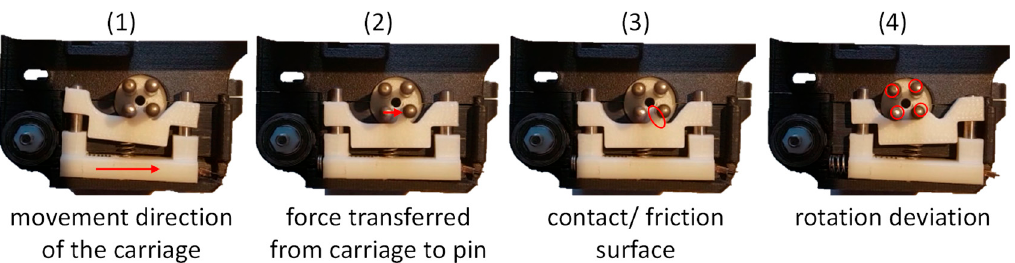
Figure 15. Representation of the sources of error during the resetting of the shift fork and the carriage generated by high roughness and inaccurate tolerances/slackness.